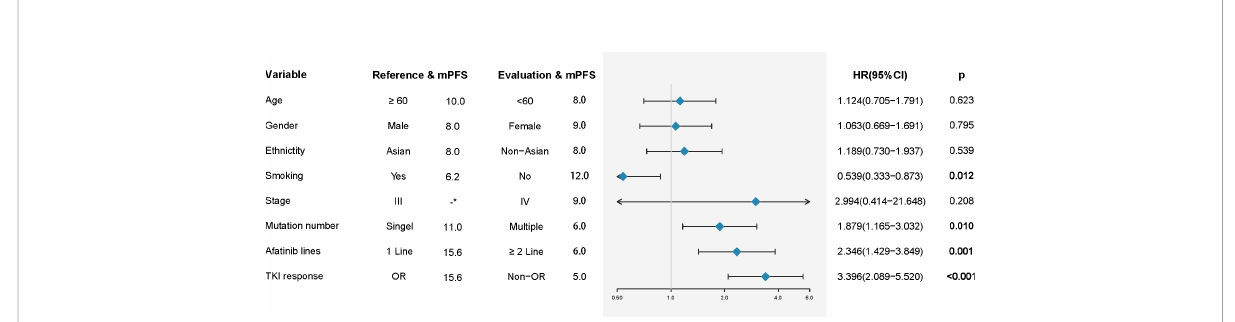
FIGURE 4 Univariate analysis for progression free survival (PFS). NA,s Not available.